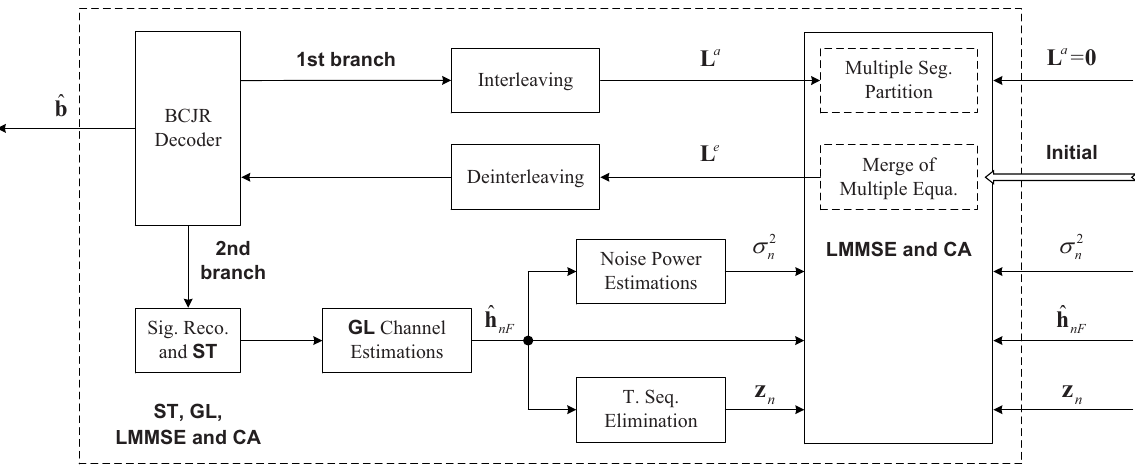
Figure 3. Turbo equalization.